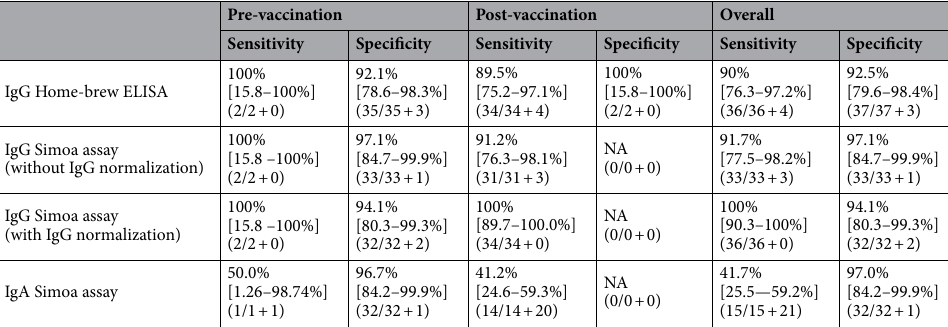
(Table 1). Two of the four post-vaccination saliva samples that were negative using the saliva laboratory-devel- oped ELISA method were positive when analyzed using the Simoa immunoassay, which further confirms the